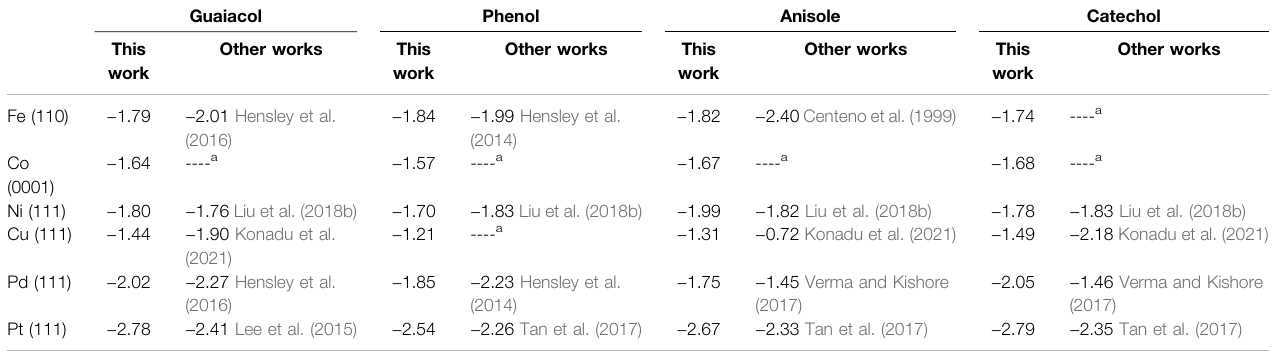
TABLE 1 | Adsorption energy (in eV) for guaiacol, phenol, anisole, and catechol on the transition metal surfaces.